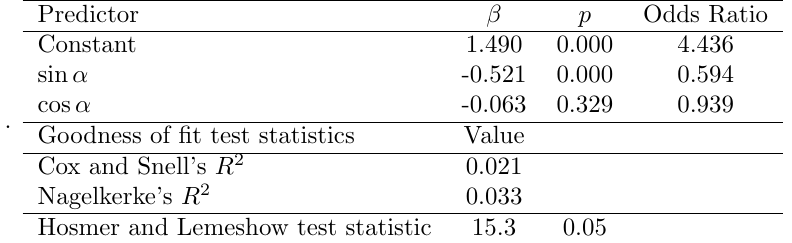
Binary Logistic Regression analysis predicting the occurrence of seasonal diseases from